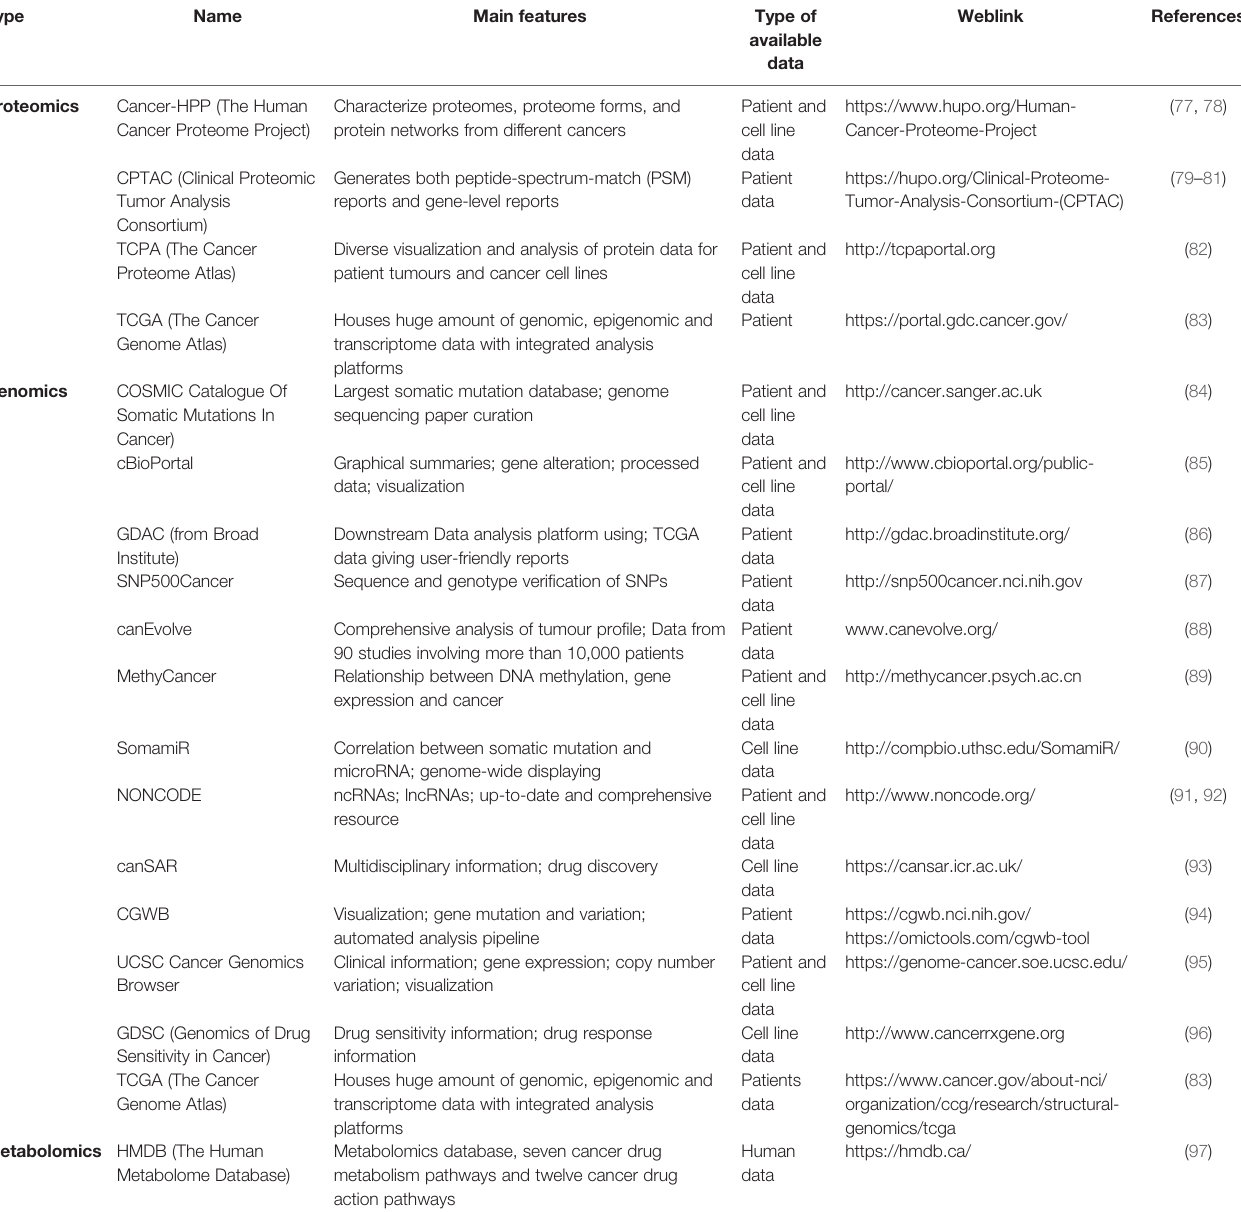
TABLE 1 | Major databases used in cancer